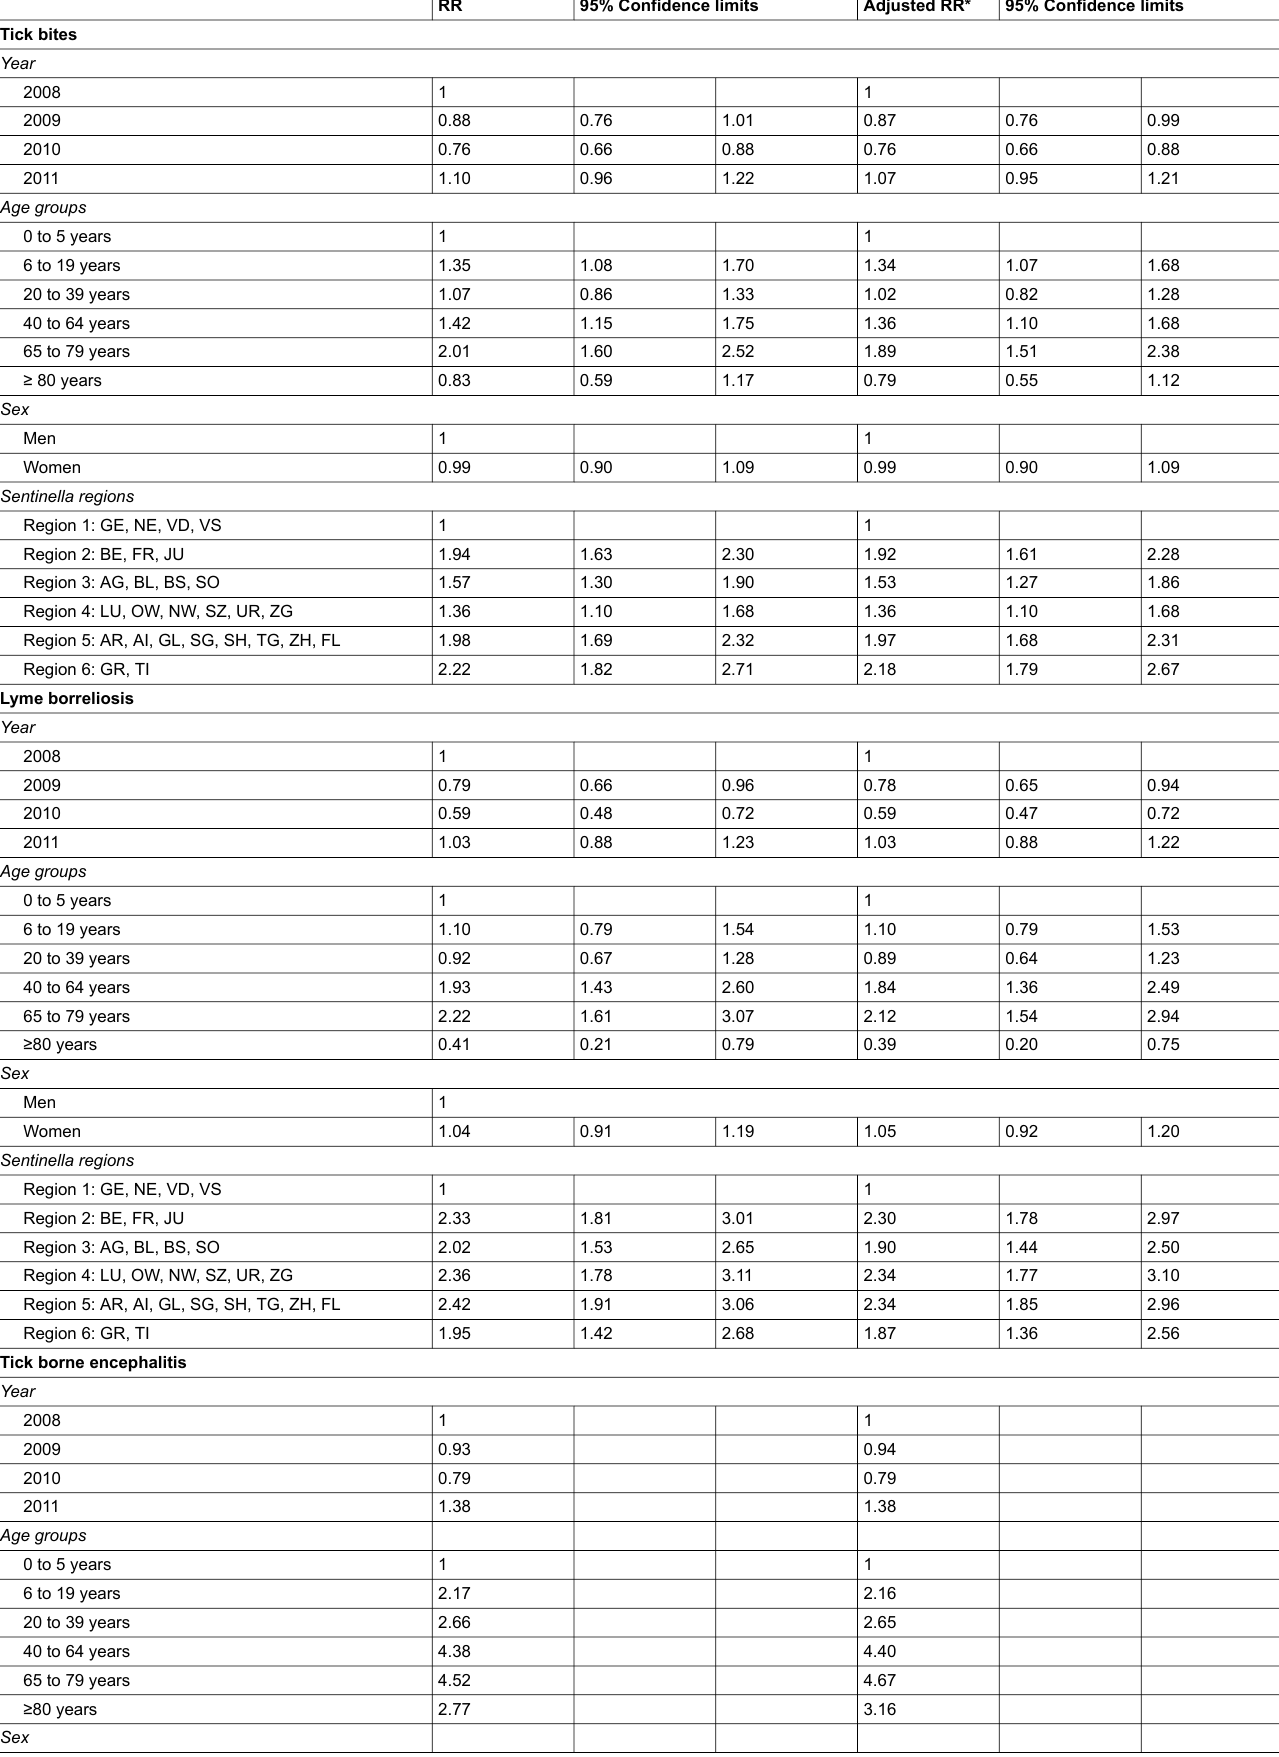
Table 5: Determinants of cases of tick bites, Lyme borreliosis and tick borne encephalitis by poisson regression in Switzerland, 2008 to 2011. RR 95% Confidence limits Adjusted